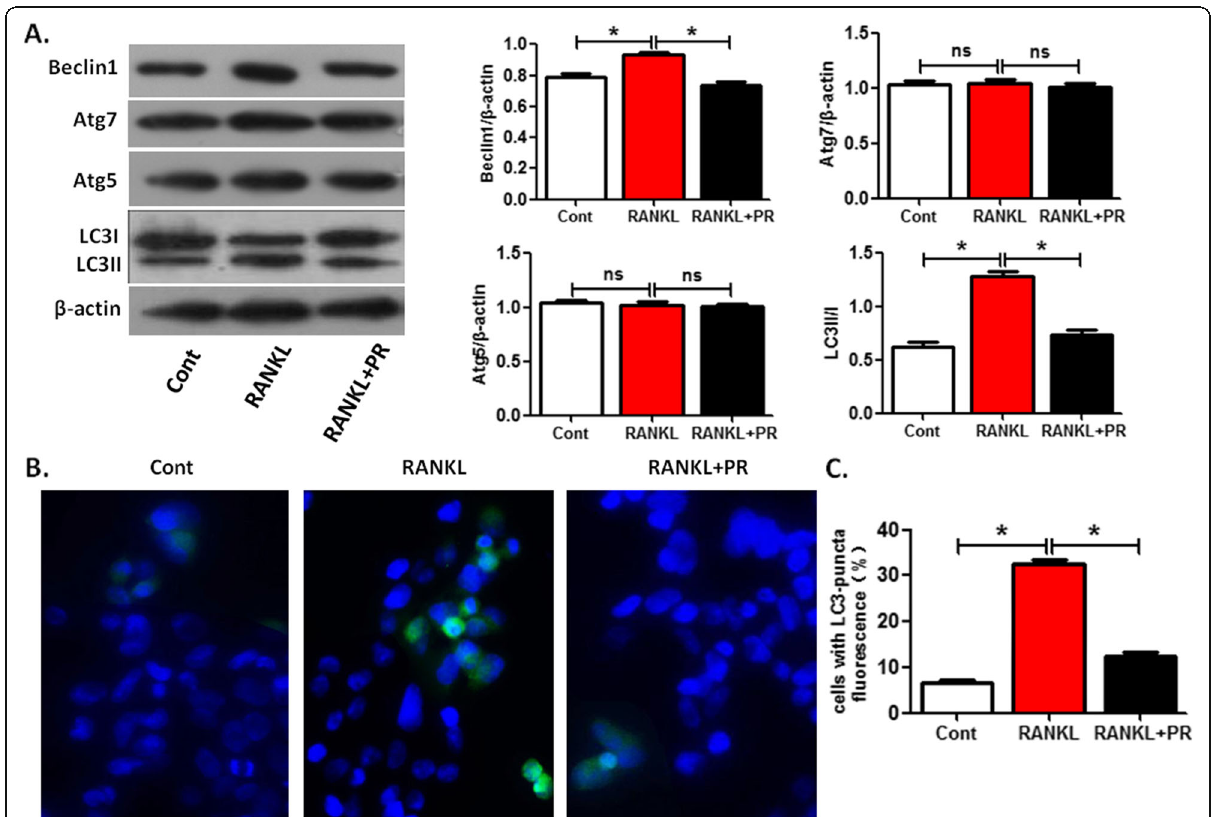
Fig. 3 Puerarin reverses RANKL-enhanced OCP autophagy. a Following treatment with or without Puerarin (50 μ M) for 6 h in the presence of RANKL, the protein level of Atg7, Beclin1 or Atg5, and the ratio of LC3II/I were detected by Western Blotting. b After treatment as described for ( a ), LC3-puncta in each group was imaged using the immunofluorescence staining and observed using the fluorescence microscope. Scale bar, 20 μ m. c Statistical diagrams exhibited the percentages of LC3-puncta positive cells (more than five dots, 50 cells/field, n = 5). Data are presented as mean ± SEM from three independent experiments. Compared between control group and RANKL group, RANKL group and RANKL+PR group, respectively, *P < 0.05. ns, no significance; PR, Puerarin; Cont, control